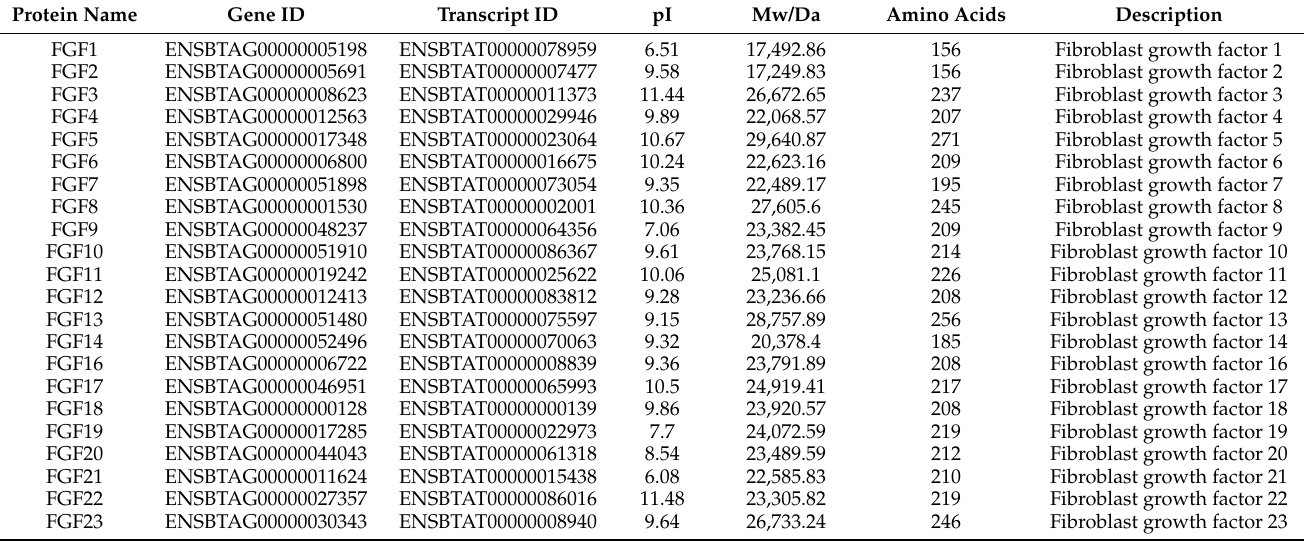
Table 1. Description of Bos taurus FGF family genes.